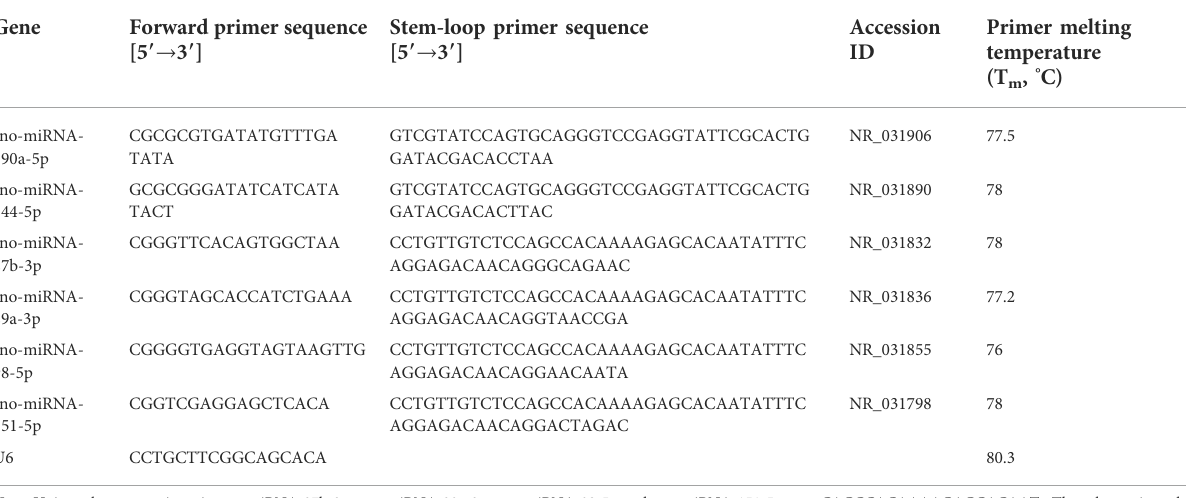
TABLE 1 qRT-PCR primers of